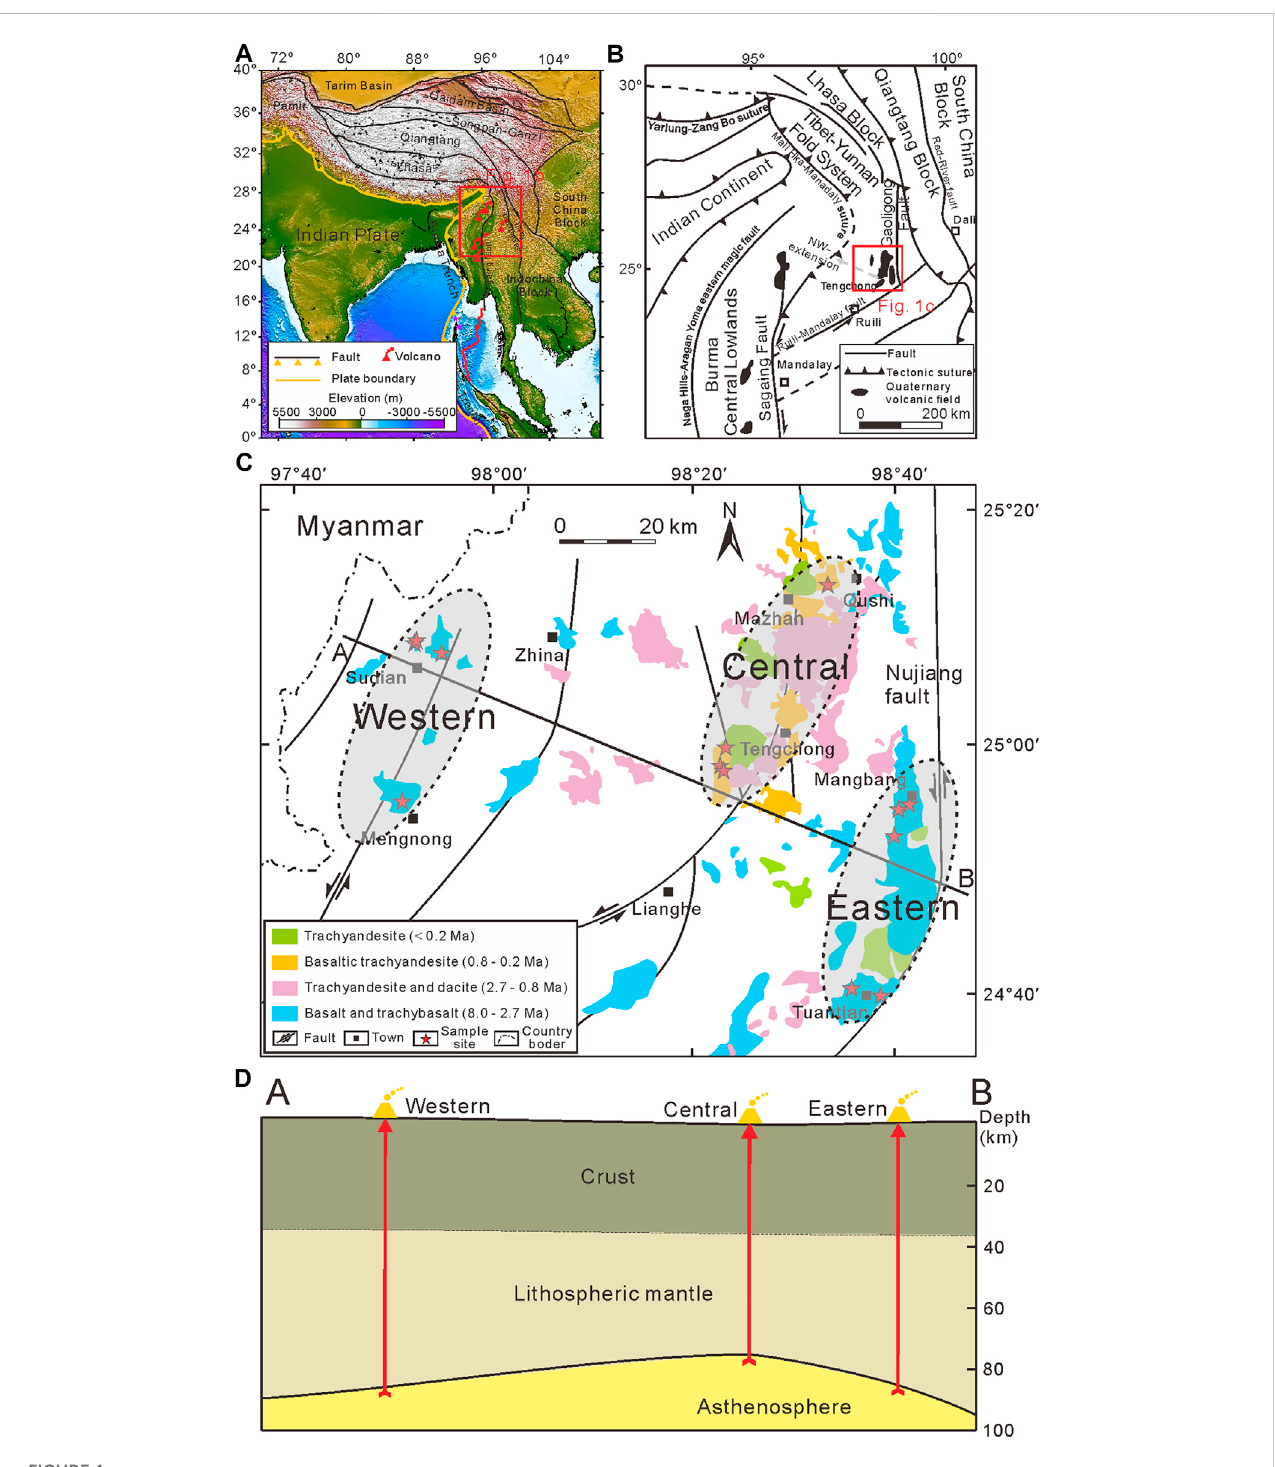
FIGURE 1 Tectonic settings around the Tengchong volcanic fi eld. (A) Major tectonic units around the Tengchong volcanic fi eld. The red triangles indicate Quaternary volcanoes in Myanmar and Yunnan, China. The volcano data are from Lee et al. (2016). The black lines delineate the major faults in and near the Tibetan Plateau (Mo et al., 2006). The red rectangle denotes the study area. (B) Location of the Tengchong volcanic fi eld and distribution of convergent boundaries and faults in SE margin of the Tibetan Plateau (modi fi ed from Zhou et al., 2012). (C) Distribution of magmatic rocks from different periods in the Tengchong volcanic fi eld (modi fi ed from Cheng et al., 2020). The gray ellipses mark the areas where representative samples were collected. (D) Cross- section ofline A ‒ Binplot (C) , illustrating thevariation inlithosphericthickness beneath theTengchong area(depth ofLAB is fromHu etal. (2012),Zhang etal. (2015); Yang et al.